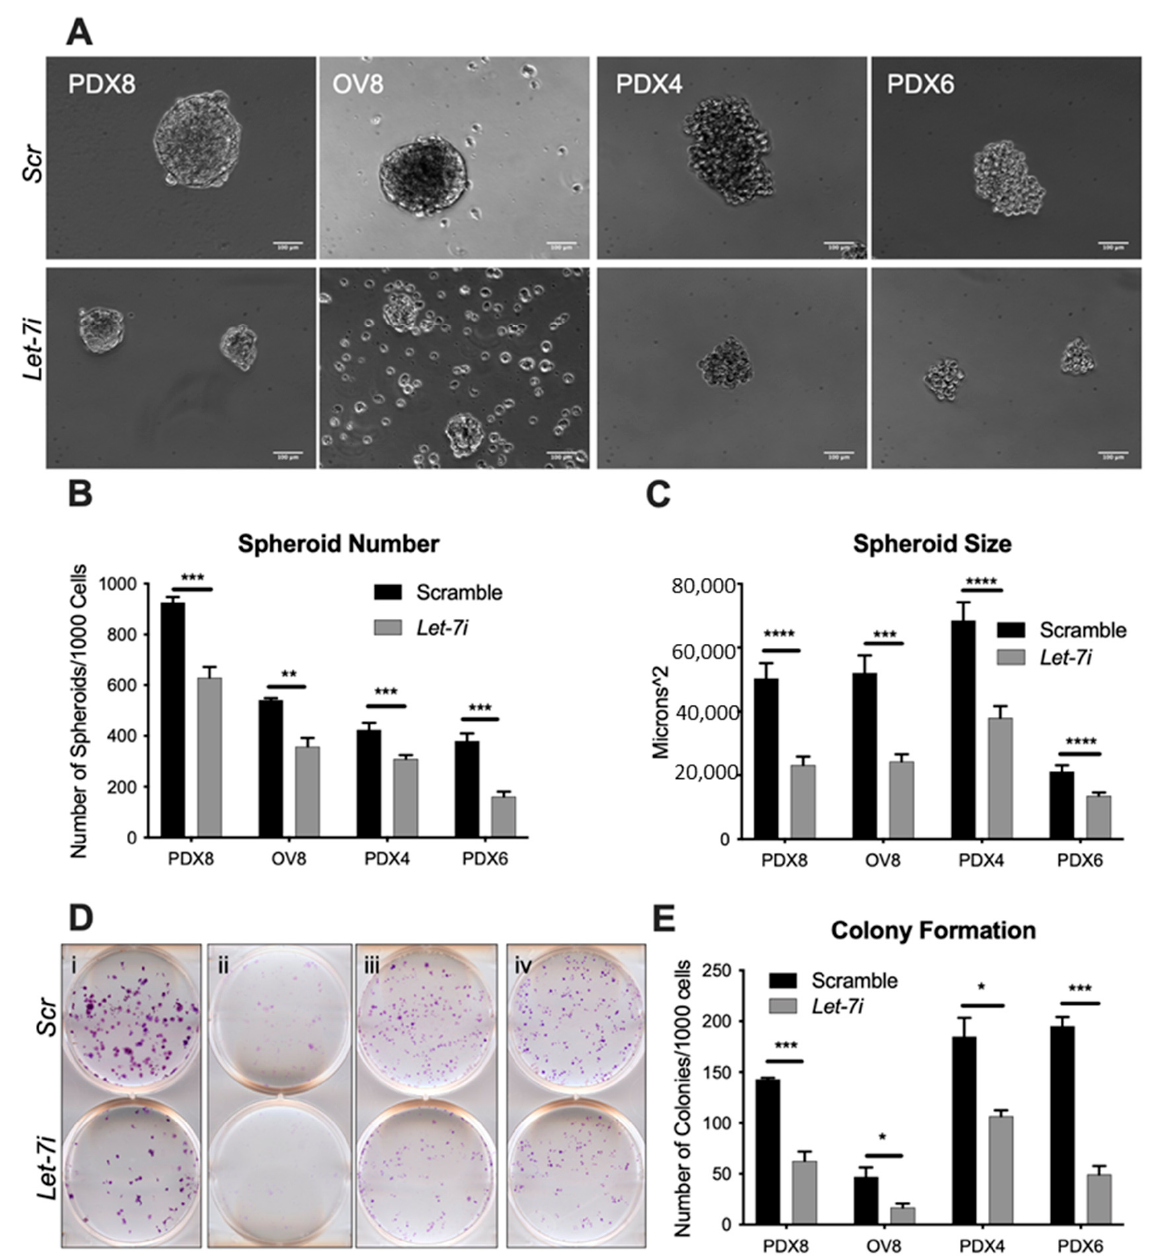
Figure 2. Let-7 represses self-renewal. Cells were grown in spheroid conditions. ( A ) Images of spheroids from cells as indicated with control (Scr, upper panel) or let-7i overexpression (lower panel). Scale bar: 100 µm. Let-7 transfection reduces number ( B ) and size ( C ) of spheroids. Let-7 over-expression results in reduced ability to form colonies ( D ). ( E ) i, ii, iii, and iv represent PDX8, OV8, PDX4, and PDX6, respectively. N = 3+ independent replicates. OV8, OVCAR8. Student’s t test was used for statistical analysis. Error bars: SEM. * p ≤ 0.05, ** p ≤ 0.01, *** p ≤ 0.001, **** p ≤ 0.0001. p value ≤ 0.05 was considered significant.